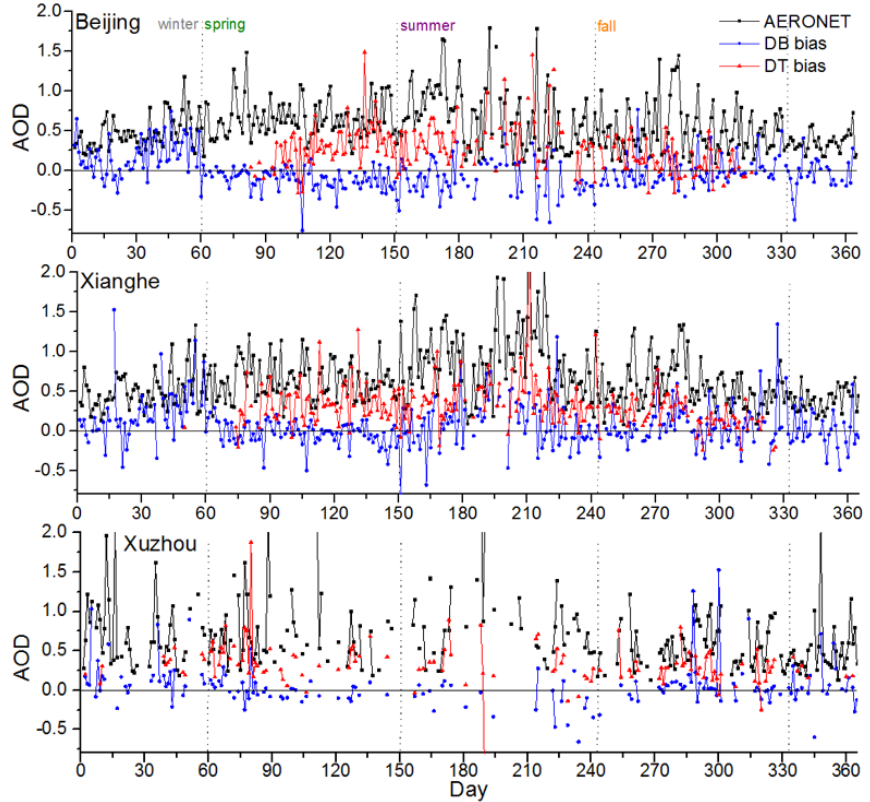
Figure 5. Daily mean values of AERONET AOD (black curve) and bias of MODIS DB and DT AOD (red and blue curves, respectively) when AERONET AOD 550 > 0.4 in northern China.